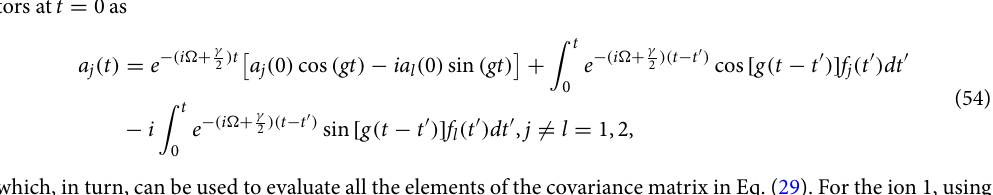
Figure 7. Population of mode 1, as function of θ = gt for ¯ n 1 = 0.35 ( T 1 = 1.42 × 10 − 4 K ( T 2 = 5.32 × 10 − ), �/ 2 π = 4 MHz, g /π = 3.1 kHz, and a heating rate Ŵ = 1.885 quanta per milisecond, such that Ŵ/ g = 0.1936 37,57